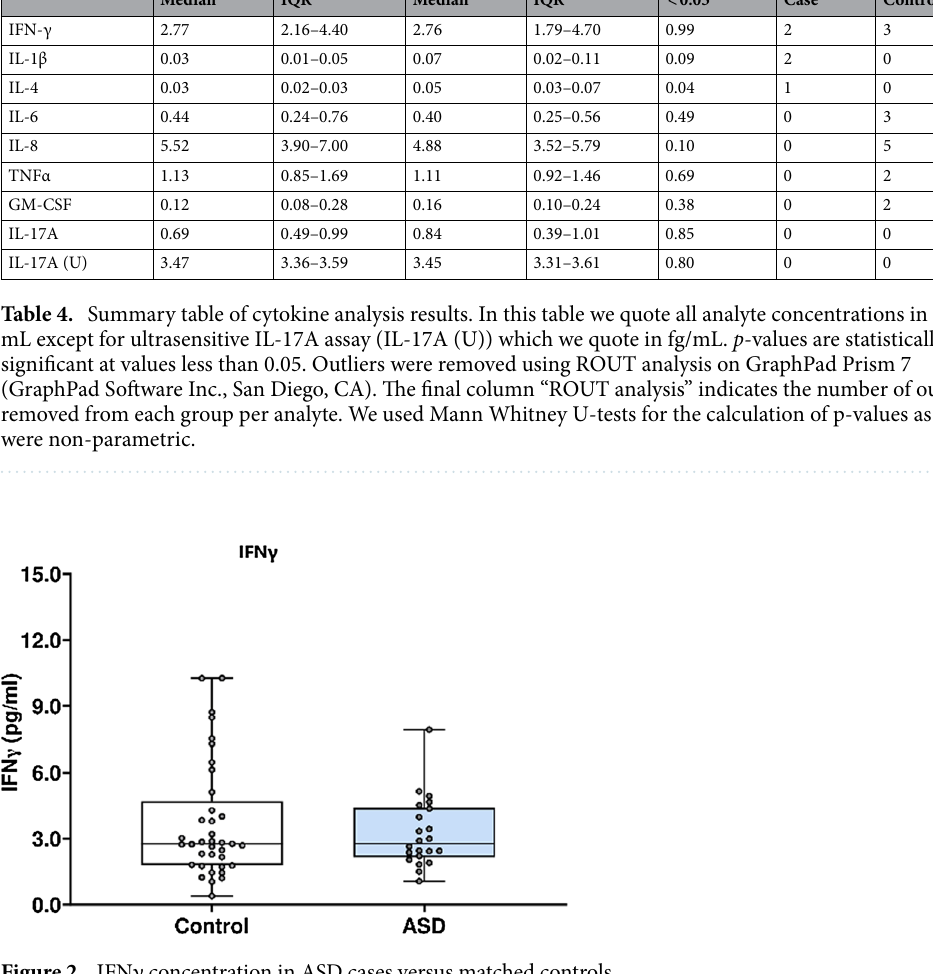
Figure 2. IFNγ concentration in ASD cases versus matched